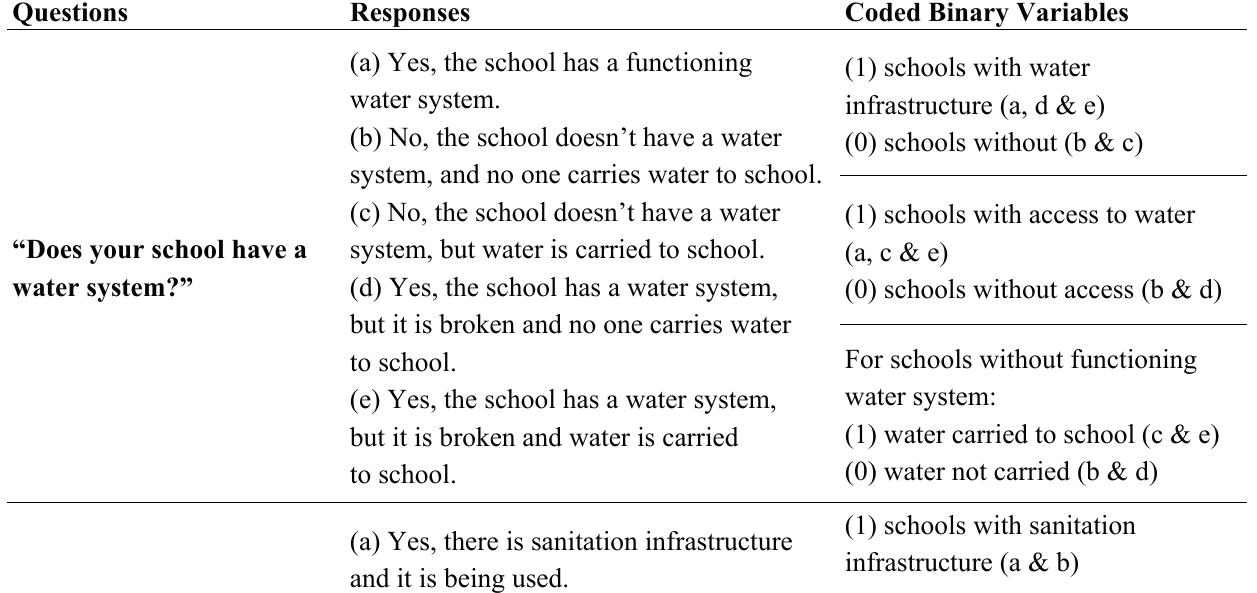
Table 1. Coding of selected